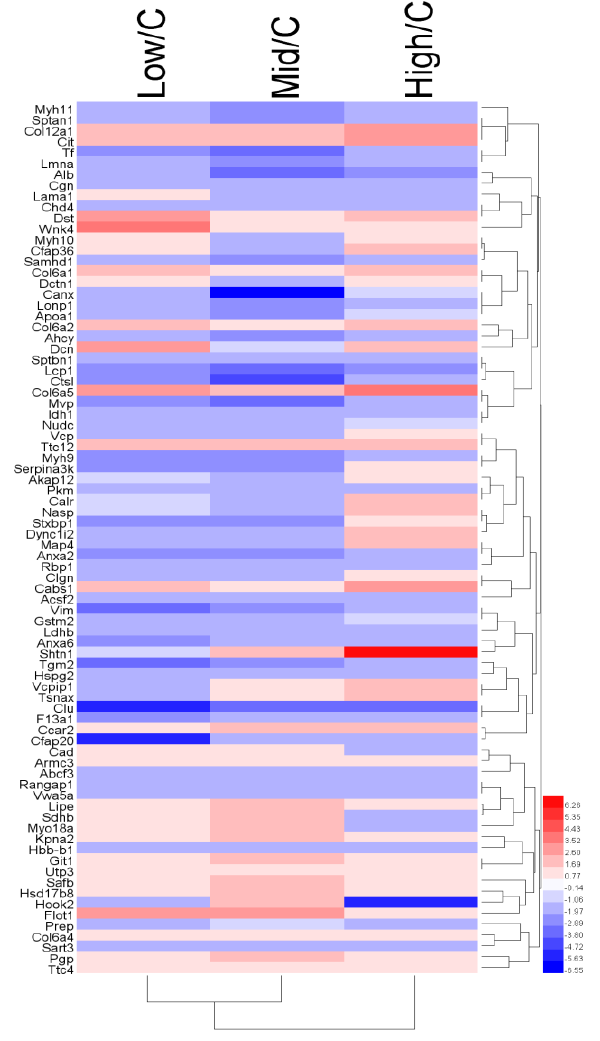
Figure 3. Hierarchical clustering showing the proteins across low, middle and high dose groups. p < 0.05.